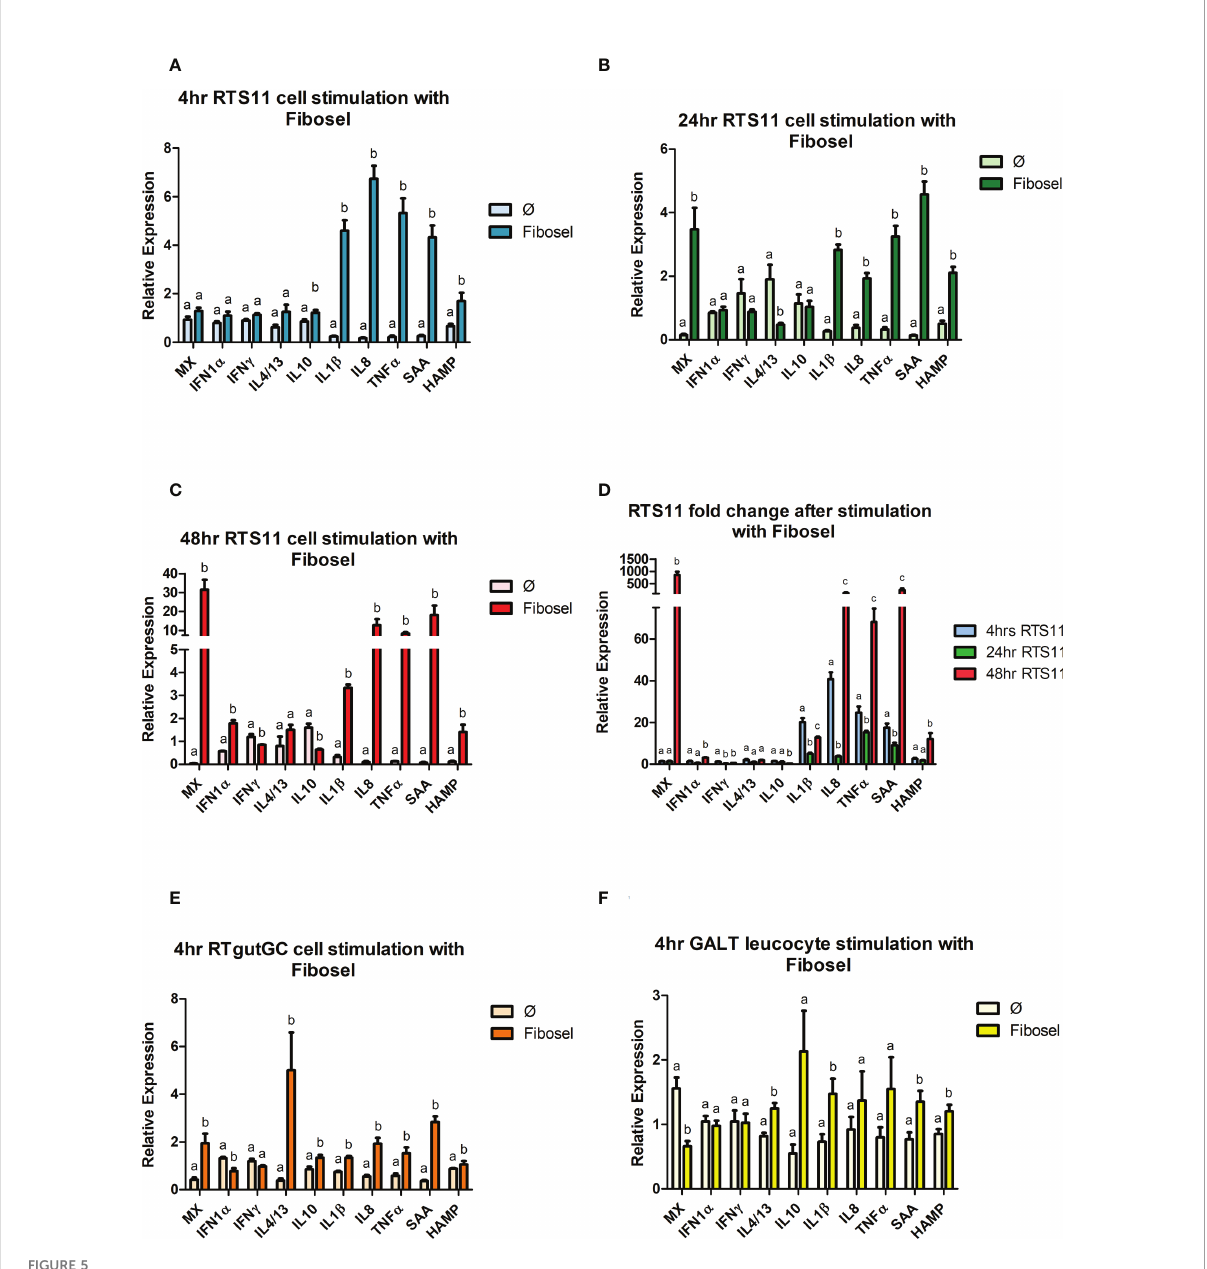
FIGURE 5 RTS11, RTgut and GALT leucocyte response to Fibosel. (A) RTS11 4hr Fibosel stimulation showing relative expression. (B) RTS11 24hr rIL1 b stimulation showing relative expression. (C) RTS11 48hr Fibosel stimulation showing relative expression. (D) RTS11 Fold Change between time points (4, 24 and 48 hr). (E) RTgutGC 4hr Fibosel stimulation showing relative expression. (F) GALT leucocyte 4hr Fibosel stimulation showing relative expression. For relative expression samples were compared between stimulated and unstimulated samples. a,b, and c denote a signi fi cant difference where p <